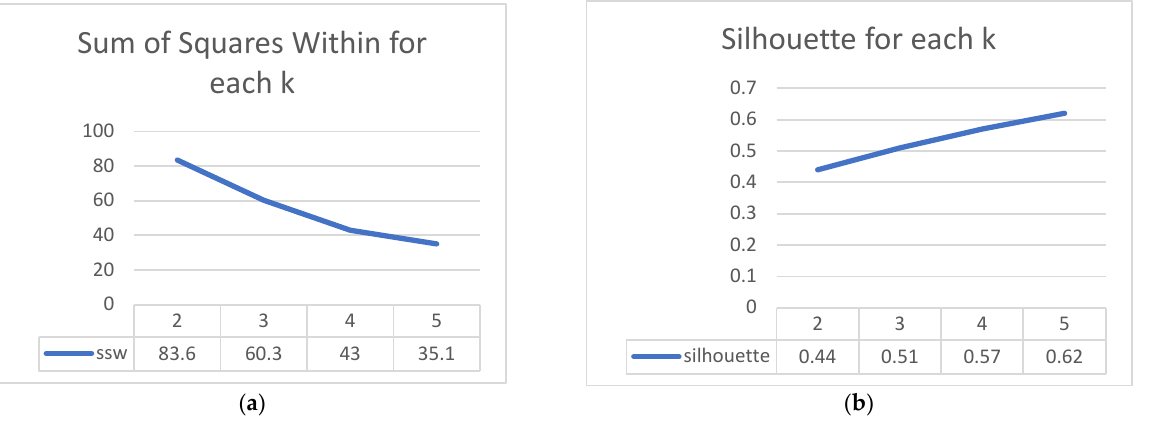
Figure 4. Clustering performance visualization. ( a ) Sum of squares within the plot showing how similar objects are in a cluster; ( b ) Silhouette score plot shows the quality of clusters.